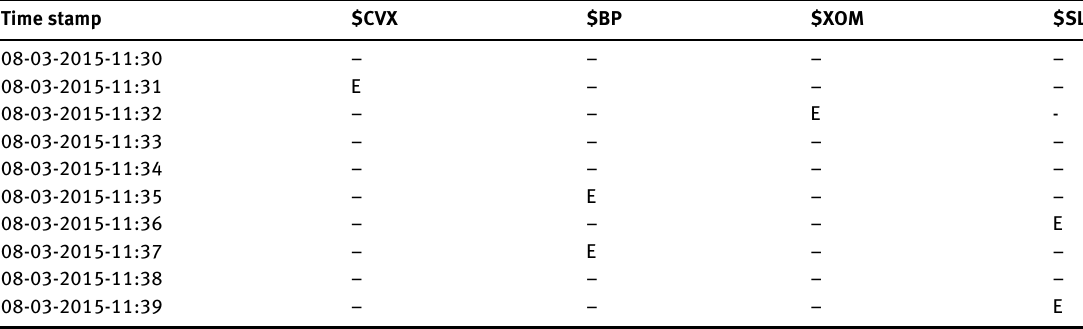
Table 4: Event Matrix as Input to Time-Series Model-Minute Frequency.